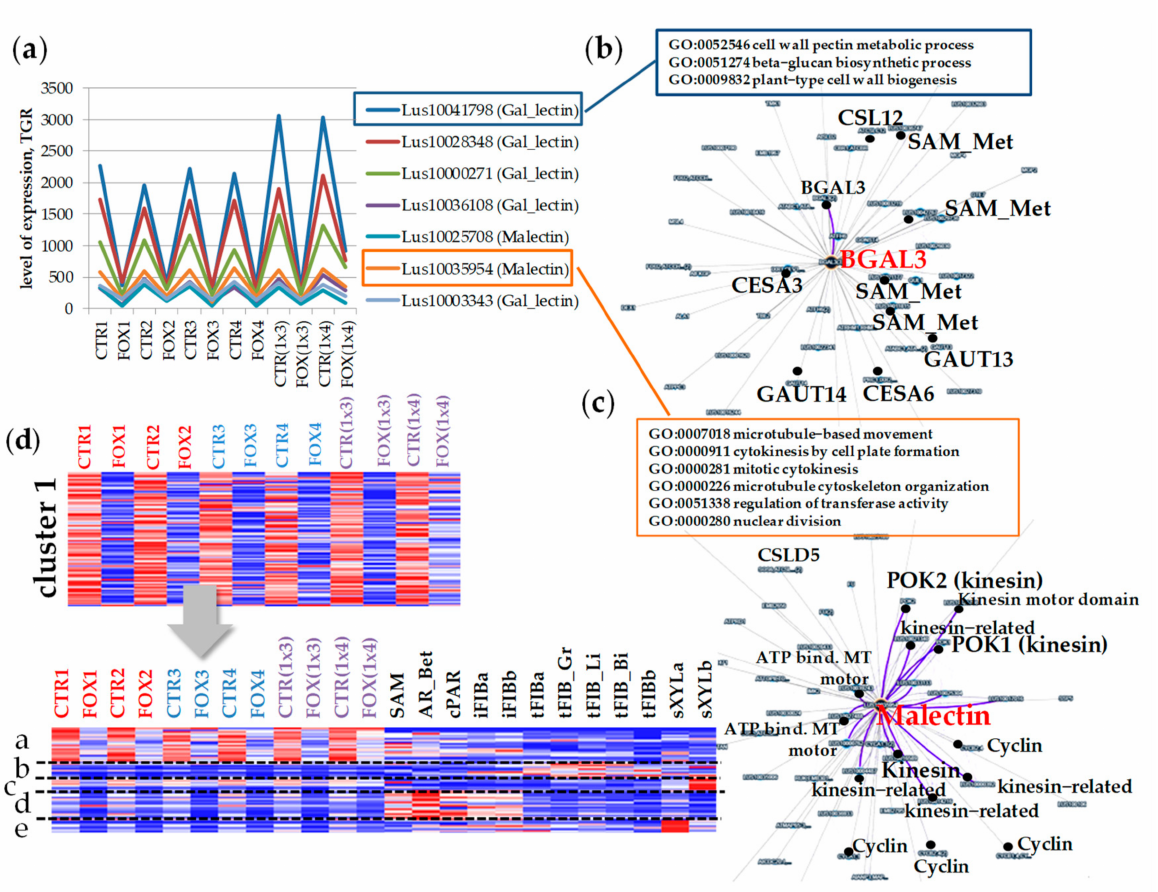
Figure 2. ( a ) The expression of several lectin genes mostly suppressed in the root tips during Fusarium oxysporum infection in all analyzed cultivars. ( b ) The coexpression network for LusB- GAL3 , its coexpressed genes, and their gene ontology (GO, for orthologous genes in Arabidopsis). ( c ) The coexpression network for Lus10035954 (Malectin family), its coexpressed genes, and their gene ontology (GO, for orthologous genes in Arabidopsis). ( d ) The cluster analysis of 63 genes downregulated after inoculation with F. oxysporum for the root and stem samples. Options for clustering: the k-means (5 clusters) method, a distance measured by the Pearson correlation, local (auto) scale. The color gradient of the red-blue heatmap reflects TGR values from minimum (blue) to maximum (red) in the row. CTR1,2,3,4,(1x3),(1x4)—untreated root tips of different flax geno- types, FOX1,2,3,4,(1x3),(1x4)—the root tips of different flax genotypes treated with F. oxysporum [10].